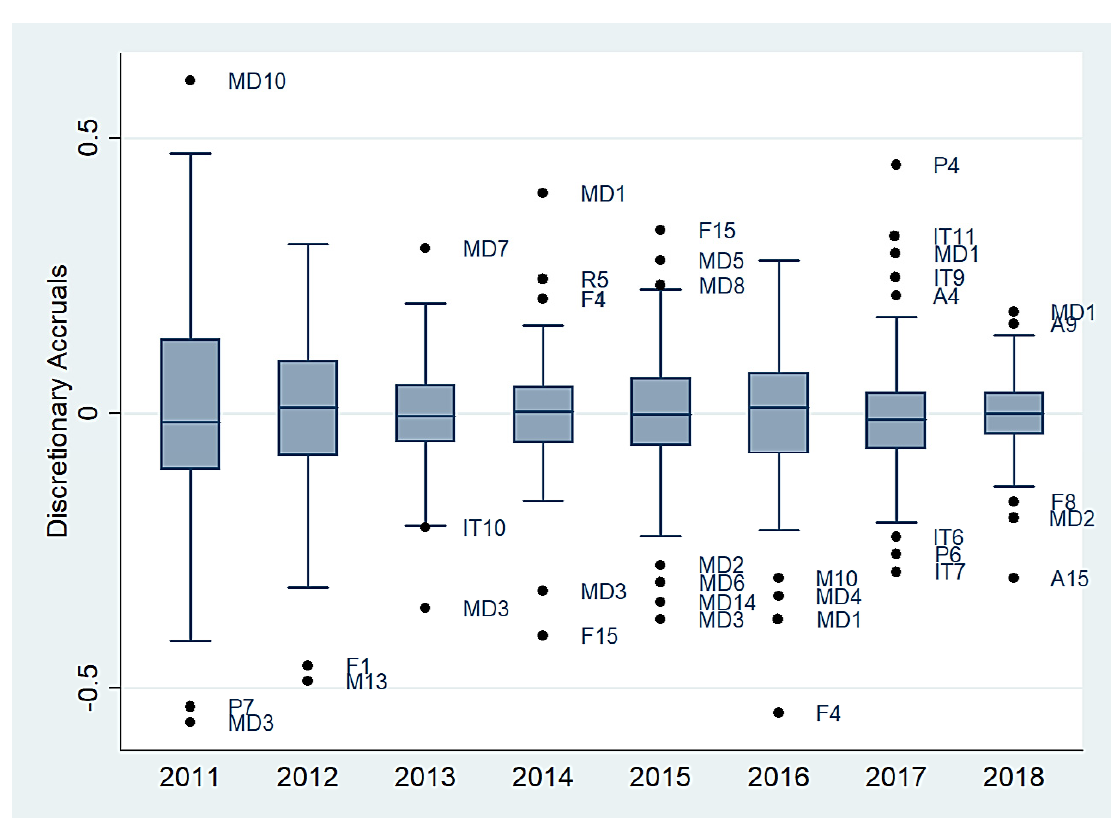
Figure 2. Box Whisker plot of discretionary accruals of all firms for the period 2011–2018. Note: The actual names of the companies are